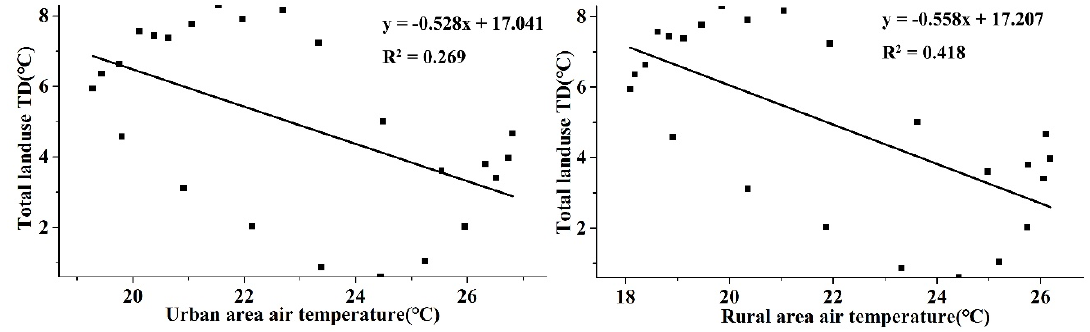
Figure 11. Correlations between total land use TD and urban and, rural temperatures.